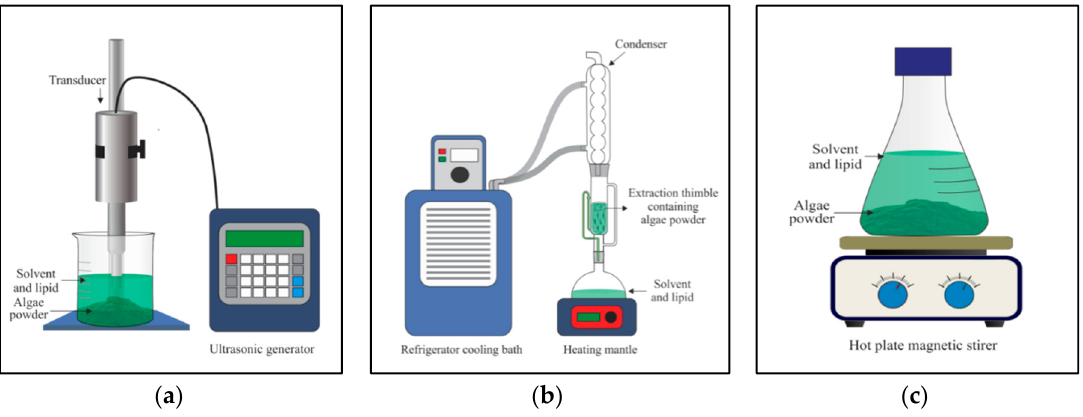
Figure 1. Schematic of lipid extraction using ( a ) ultrasonication, ( b ) Soxhlet extraction, and ( c ) solvent extraction method.